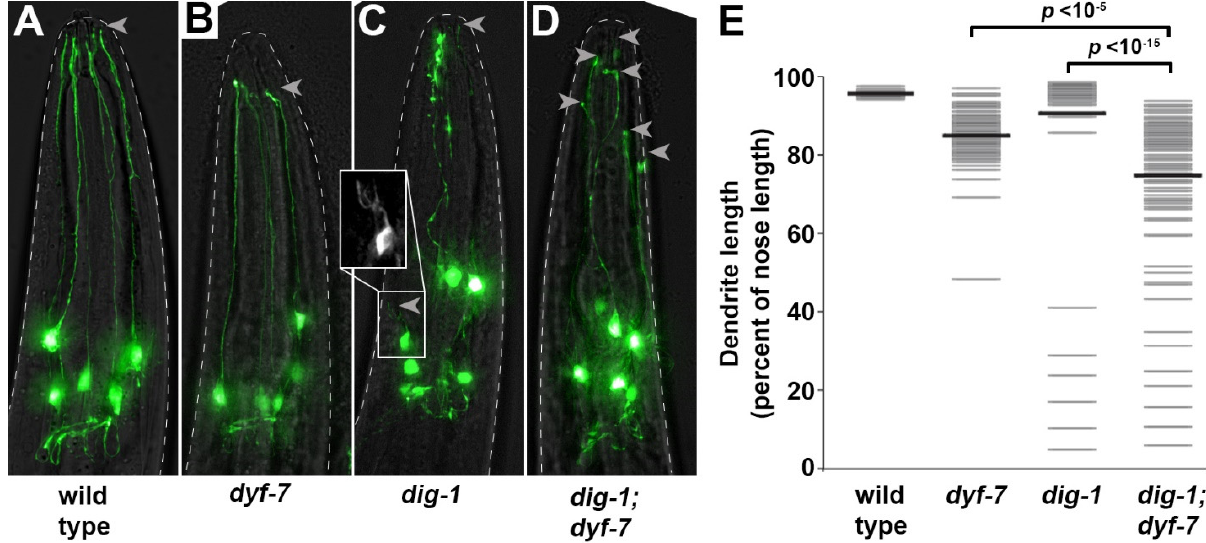
Figure 5. Rare IL2 dendrite extension defects in dig-1 mutants are enhanced by loss of dyf-7. Heads of ( A ) wild-type, ( B ) dyf-7 ( ns119 ), ( C ) dig-1 ( n1321 ), and ( D ) dig-1 ( n1321 ); dyf-7 ( ns119 ) animals at the L4 stage, showing dendrite extension defects. Arrowheads, dendrite endings. A severely shortened dendrite is boxed and magnified in ( C ). Animals express klp-6 pro:GFP. ( E ) Quantification of phenotype expressivity. Dendrite lengths were measured as a fraction of the distance from the cell body to the nose tip. Gray bars, individual dendrites; black bars, population mean. n > 90 per genotype except wild-type n = 30. p- values, Mann–Whitney U test with Bonferroni correction.